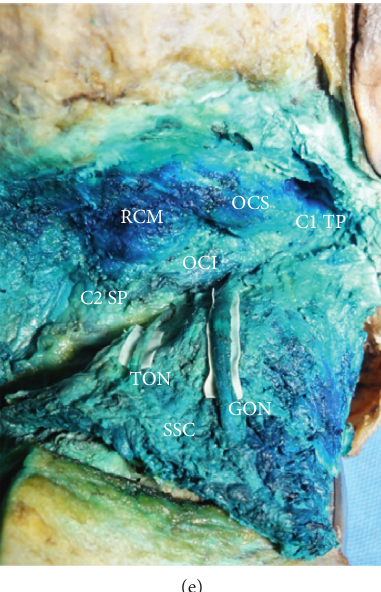
Figure 2: The images of the injectate distribution. (a) Test cadaver post left-sided injection with 2ml of injectate. The dissection revealed coating of the second cervical nerve root. (b) Test cadaver post left-sided injection with 5ml of injectate. Dissection revealed coating of the mastoid tip of sternocleidomastoid. (c) Test cadaver post left-sided injection with 2ml of injectate. The dissection revealed coating of GON without coating of TON. (d) Test cadaver post right-sided injection with 3.5ml of injectate. The dissection revealed coating of both GON and TON. (e) Test cadaver post right-sided injection with 5ml of injectate. The dissection revealed coating of both GON and TON. GON: greater occipital nerve; TON: third occipital nerve; LON: lesser occipital nerve; GAN: great auricular nerve; OCI: obliquus capitis inferior; OCS: obliquus capitis superior; RCM: rectus capitis major; SSC: semispinalis capitis; SCM: sternocleidomastoid; SpCap: splenius capitis; Trap: trapezius; TP: transverse process; SP: spinous